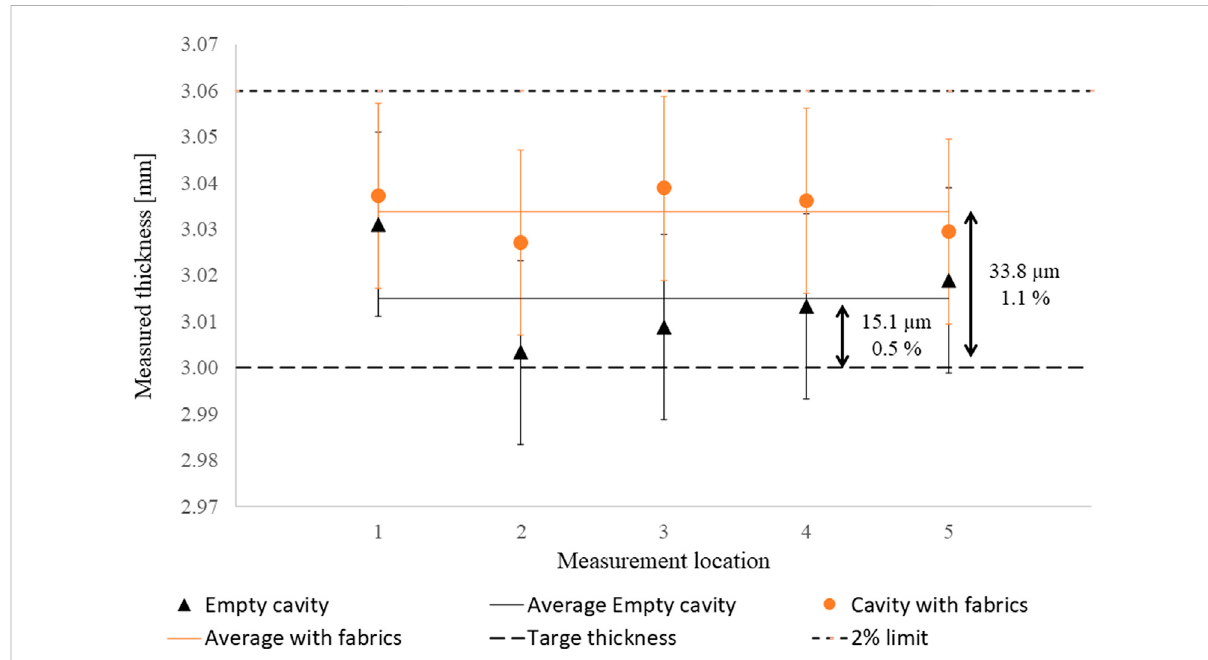
FIGURE 6 Thickness of the plasticine blocks in the fi ve locations with an empty cavity and fabrics in the cavity. The average of the fi ve location is represented by a horizontal line. The error bars represent the caliper error (±20 µm) as this error is larger than the difference between the fi ve measurements (average cv